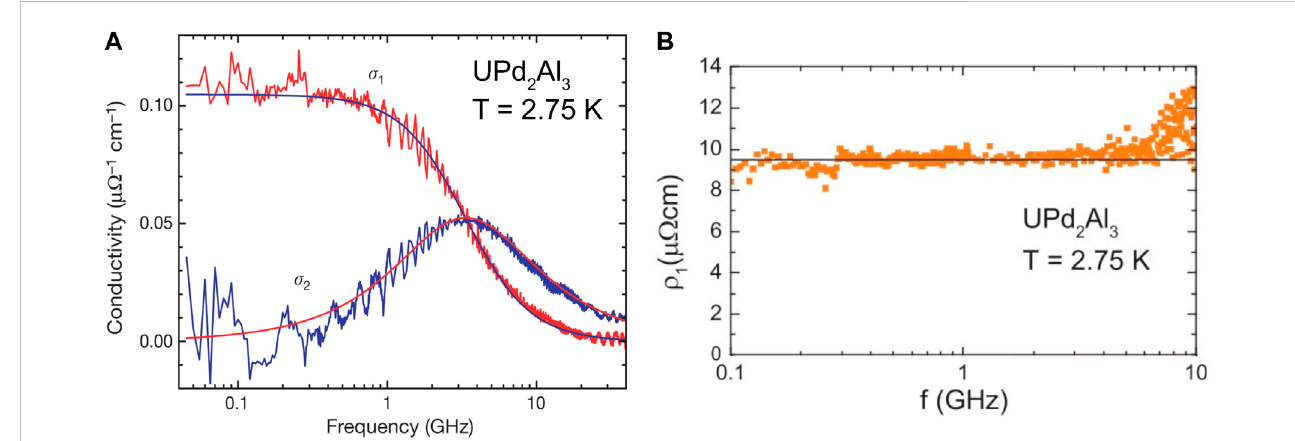
FIGURE 7 Optical conductivity of an MBE fi lm of UPd 2 Al 3 at 2.75 K in the microwave regime. (A) The real and imaginary parts of the conductivity, σ 1 and σ 2 , are shown together with a Drude fi t to both components that yielded the parameters σ 0 = ne 2 τ / m = .105 μ Ω − 1 cm − 1 and τ = 4.8 · 10 – 11 s/rad. (B) Real part of the resistivity, ρ 1 ( ω ) = σ 1 ( ω )/| σ ( ω )| 2 , of the same data. The solid line includes the ω 2 term estimated as explained in the text. The ω 2 upturn is not resolved on the plotted scale. Panels A and B are adapted from (Schef fl er et al., 2005) and (Schef fl er et al., 2013),